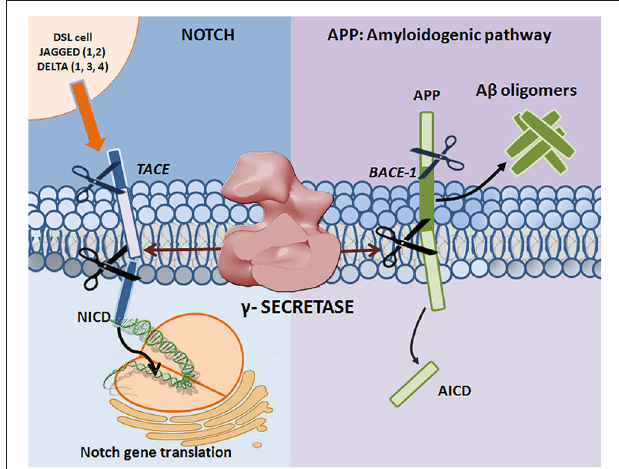
FIGURE 1 | Proteolytic processing of APP and Notch . Mature Notch receptors are activated by binding to ligands (Jagged-1, -2 and Delta-like -1, -3, and -4) located on adjacent signal-presenting cells. An induced conformational change exposes a cleavage site (S2) for ADAM family metalloproteases that cleave Notch at an extracellular, membrane-proximal region. The membrane-bound Notch segment that results from this cleavage, known as Notch Intracellular Truncation domain (NEXT), is a γ -secretase substrate (Kopan and Ilagan, 2009). γ -Secretase performs the subsequent cleavage at S3 (De Strooper et al., 1999), releasing Notch intracellular domain (NICD) from the membrane and allowing for signal transduction through binding with the CBL-1, Su(H), Lag-1 (CSL; Schroeter et al., 1998; Struhl and Adachi, 1998) family of DNA binding proteins. APP undergoes sequential proteolytic processing first by β -secretase (BACE1, aspartyl protease) and then by γ -secretase, in the amyloidogenic pathway. The first cleavage results in ectodomain shedding in which the amino-terminal of APP is removed, yielding a soluble APP derivative (sAPP β ) and a carboxy-terminal membrane stub known as β CTF (C99). β CTF is a substrate for γ -secretase, and is cleaved in its transmembrane domain to form AICD and the potentially toxic A β . Mutations in presenilin (the catalytic subunit of γ -secretase) and APP can lead to increases in the A β 42 to A β 40 ratio, resulting in A β deposition and plaque